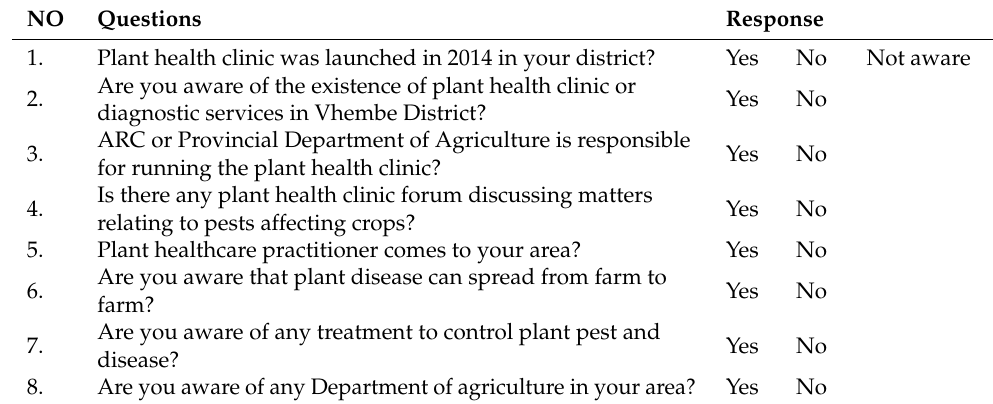
Table A2. Awareness about plant health clinics.